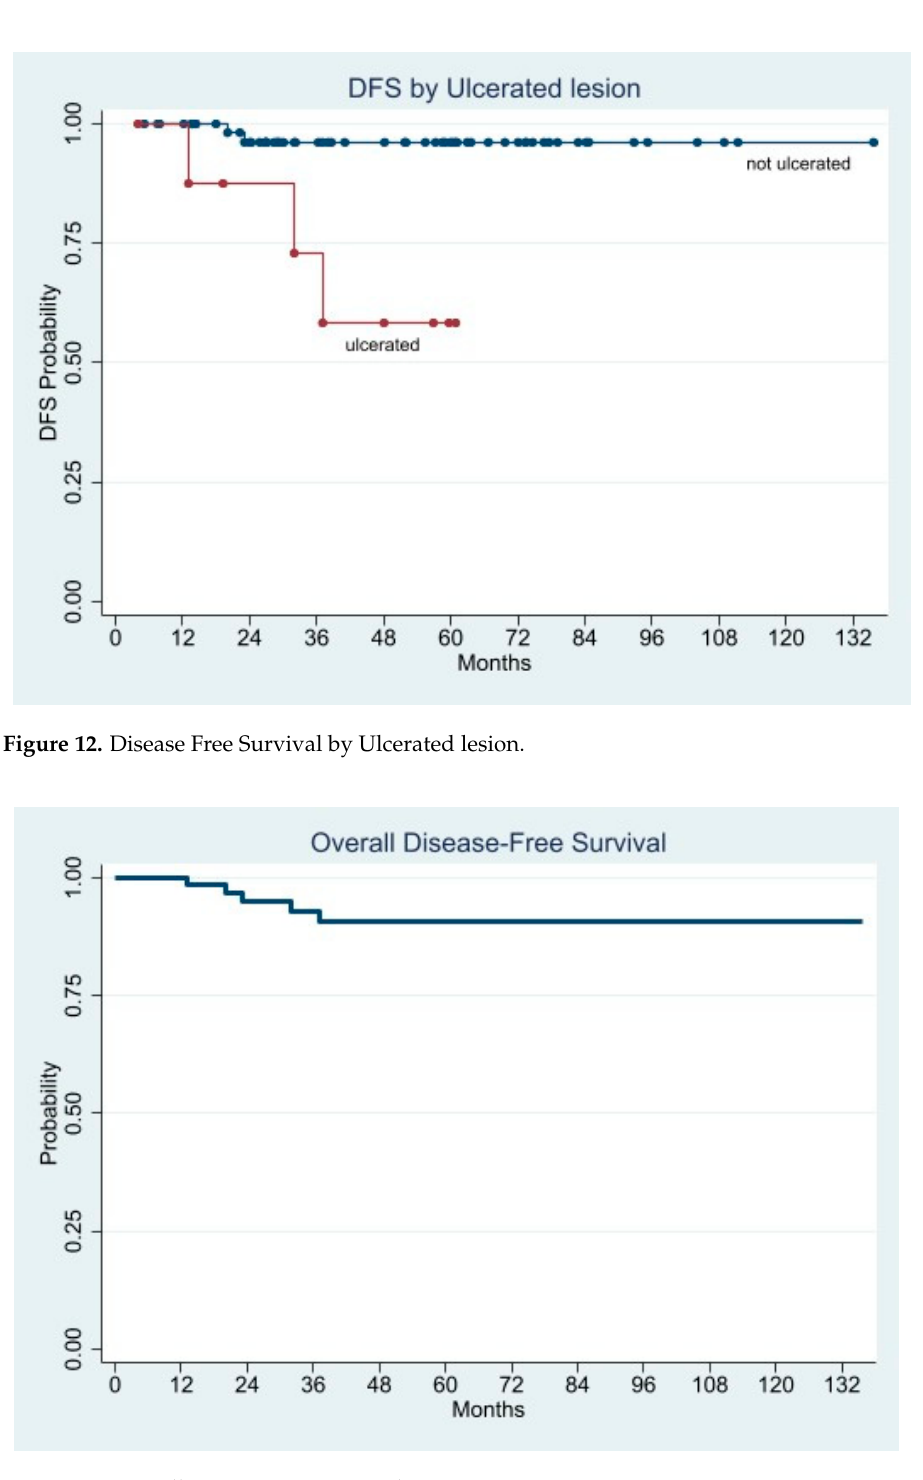
Figure 11. Disease Free Survival by Tumor size.